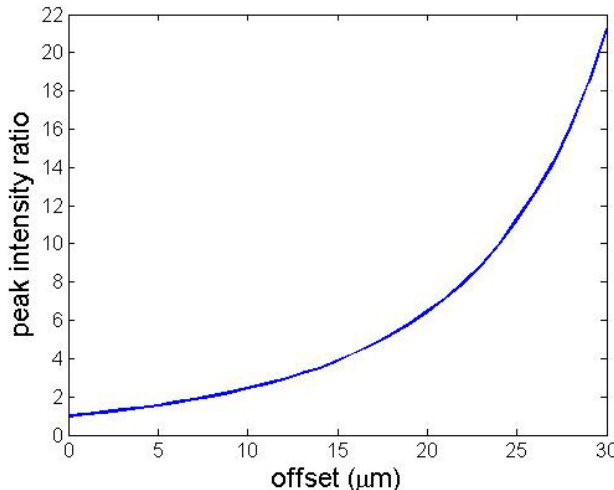
FIG. 9. (Color) Sensitivity of the peak intensity ratio to the beam